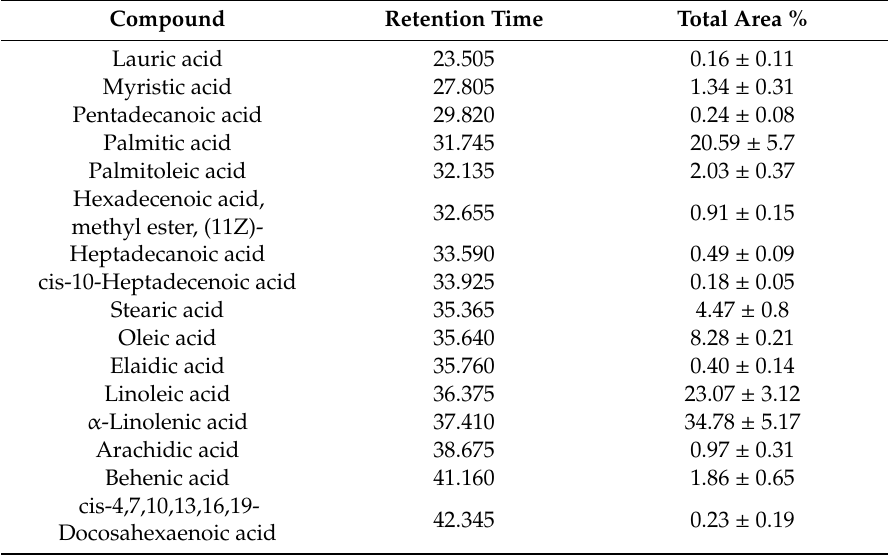
Table 6. Fatty acid composition of C. alata